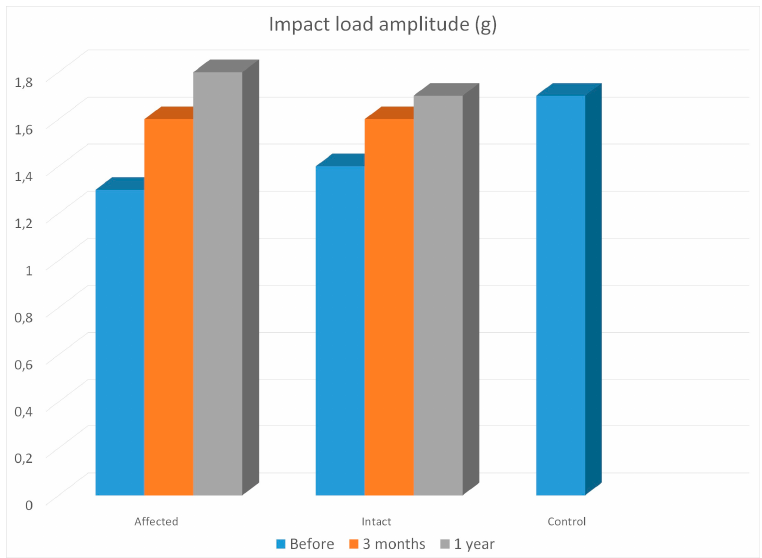
Figure 3. Load amplitudes (g) for the affected and intact legs at different time points (before group.